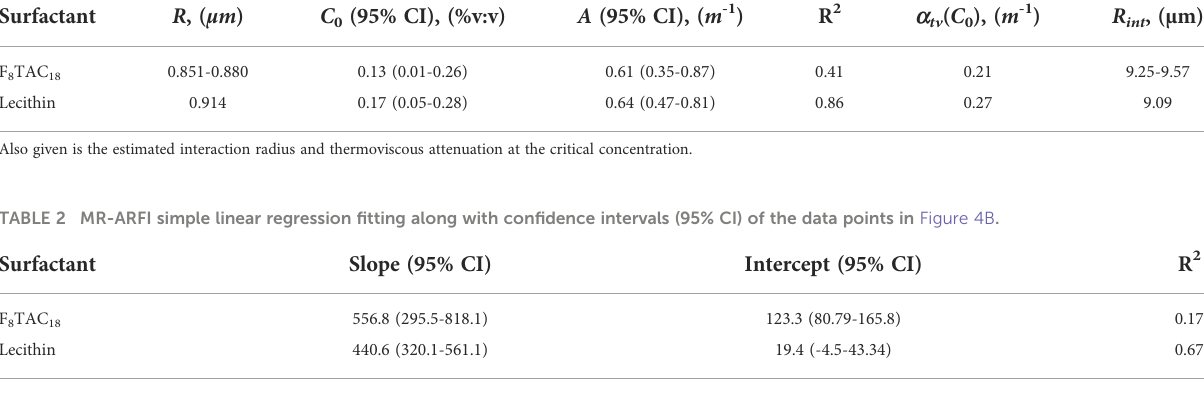
TABLE 1 Fit constants from equation 4 along with con fi dence intervals (95% CI). Surfactant